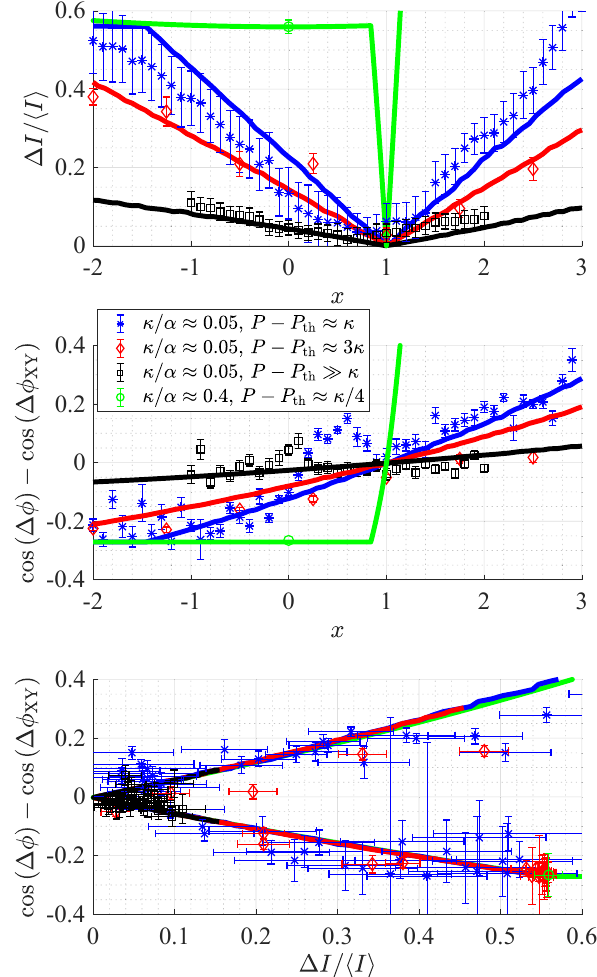
Figure 3: House network state as a function of the laser loss at various operation regimes – comparison of measurements (markers)totheory(solidlines)forallcasesofcouplingstrengthand pump strength of Table 1. Error bars are estimated as 67% con fi dence intervals. (a) The amplitude heterogeneity versus x . (b) ThephasedeviationfromtheXYgroundstatephaseversus x .(c)The phase deviation from the XY ground state phase versus the amplitude heterogeneity for all cases. The upper (lower) branch of the V-shape curve corresponds to x values larger (smaller) than